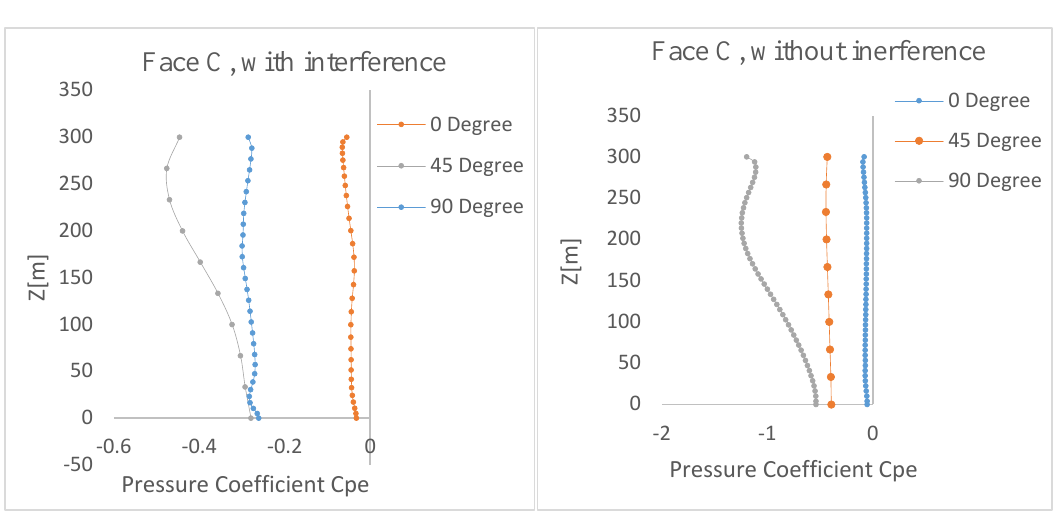
Fig. 8. Variation of pressure coefficient with height for Face C with Interference and without